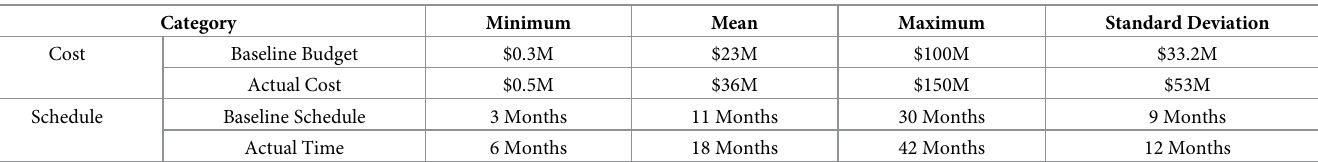
Table 4. Descriptive data analysis.